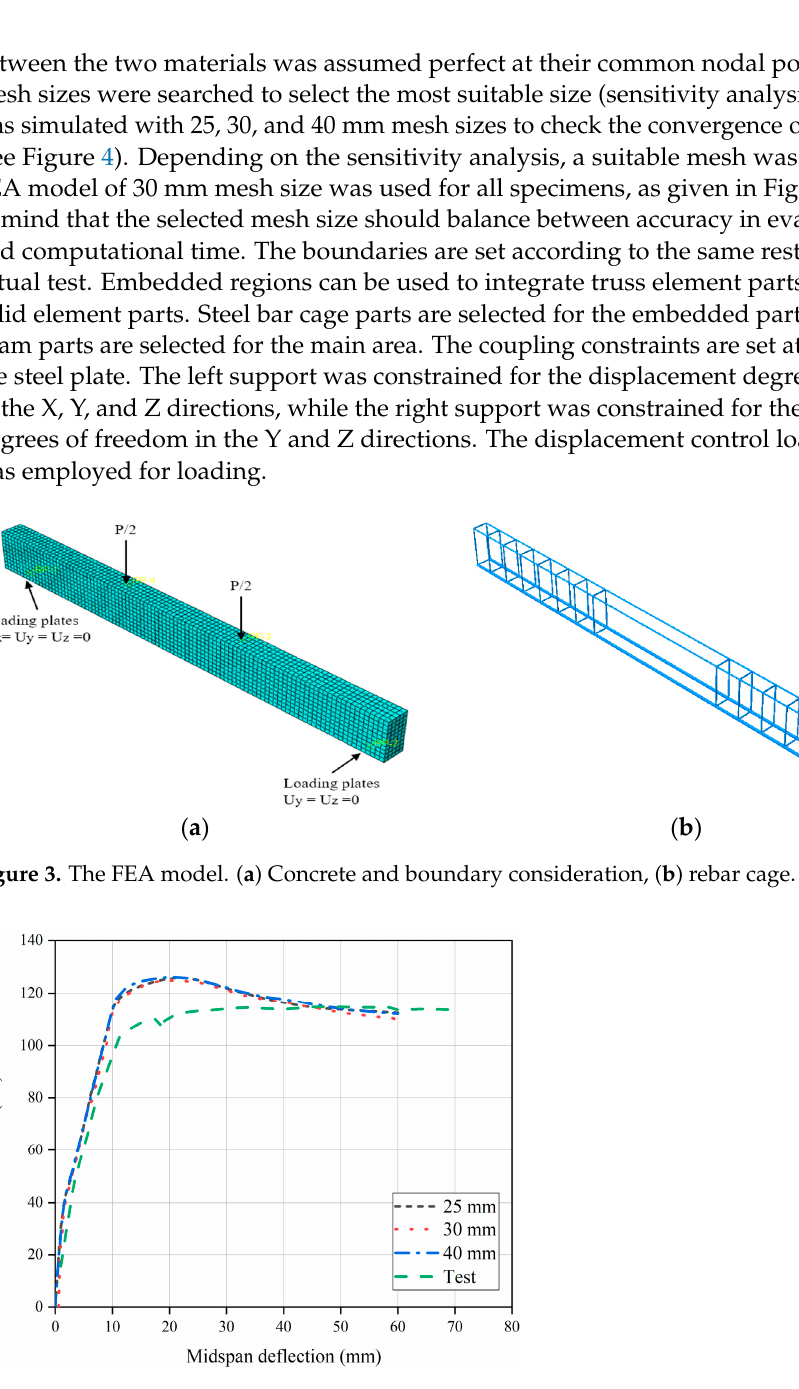
Figure 4. Mesh size effect of specimen C30R50F1.